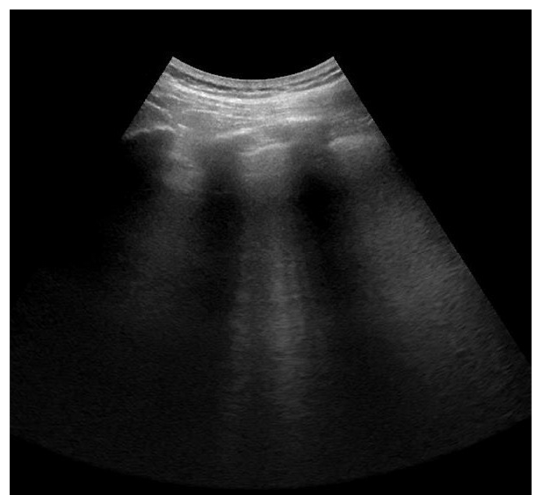
Figure A2. Well-spaced B-lines (B1)—score 1.